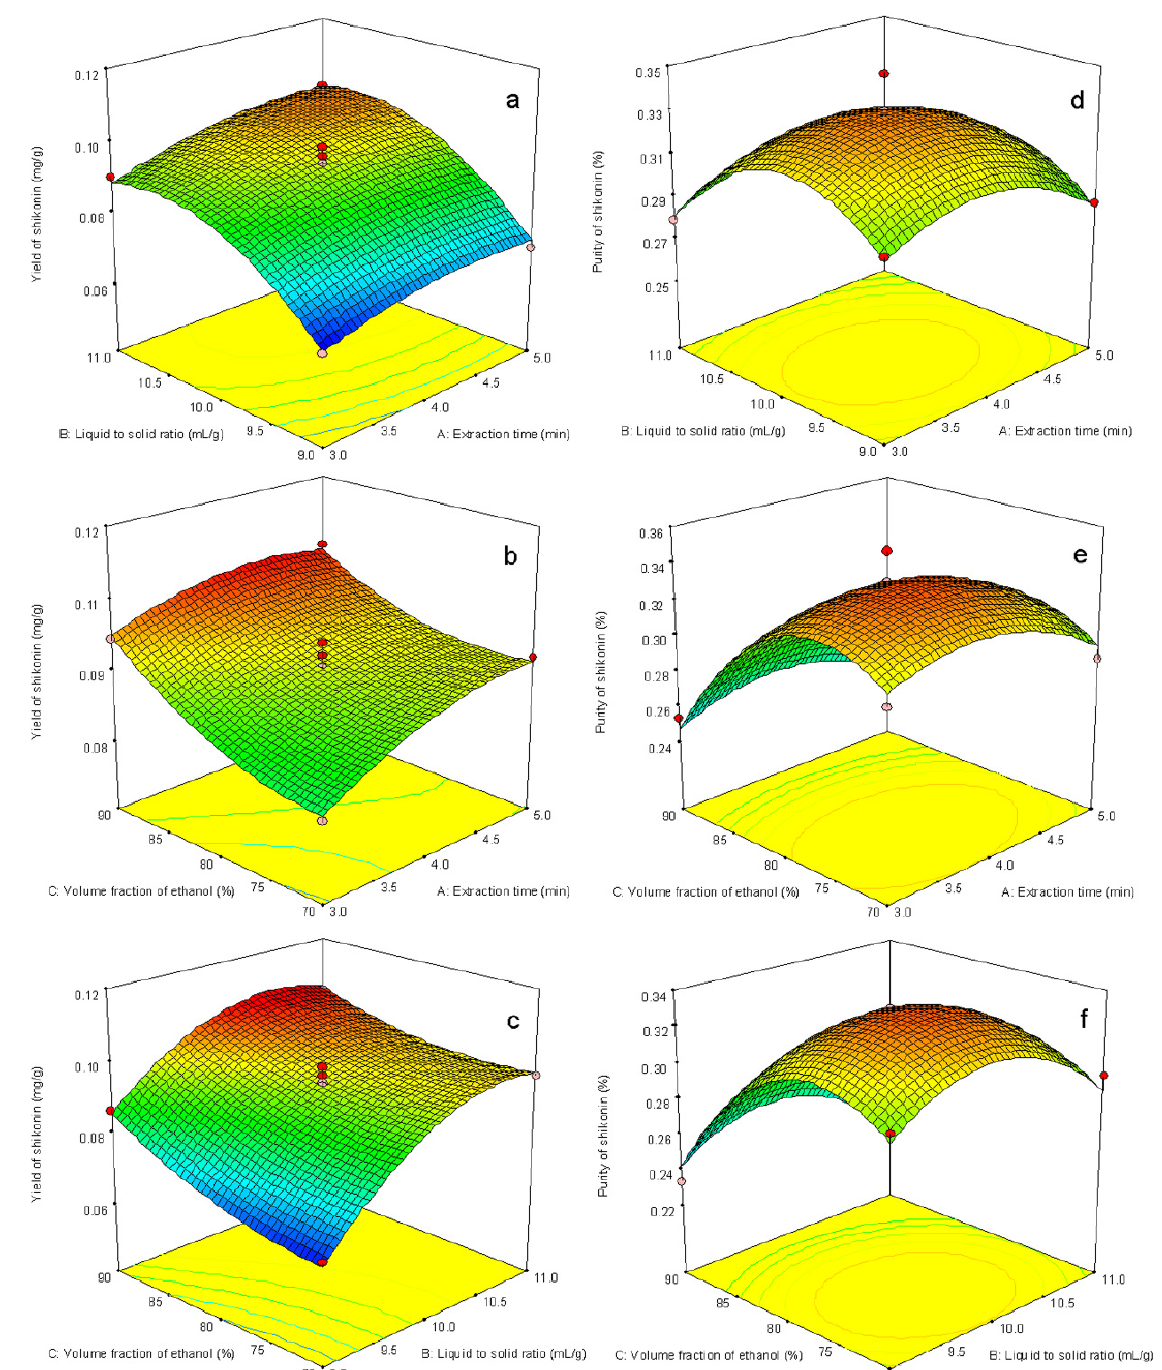
Figure 6. The 3D response surface of yield and purity affected by the varying homogenate extraction time and liquid to solid ratio ( a , d ), the varying homogenate extraction time and volume fraction of ethanol ( b , e ), and the varying liquid to solid ratio and volume fraction of ethanol ( c , f ). The values of the fixed parameters are as follows: ( a , d ): volume fraction of ethanol of 80%; ( b , e ): liquid to solid ratio of 10 mL/g; ( c , f ): homogenate extraction time of 4